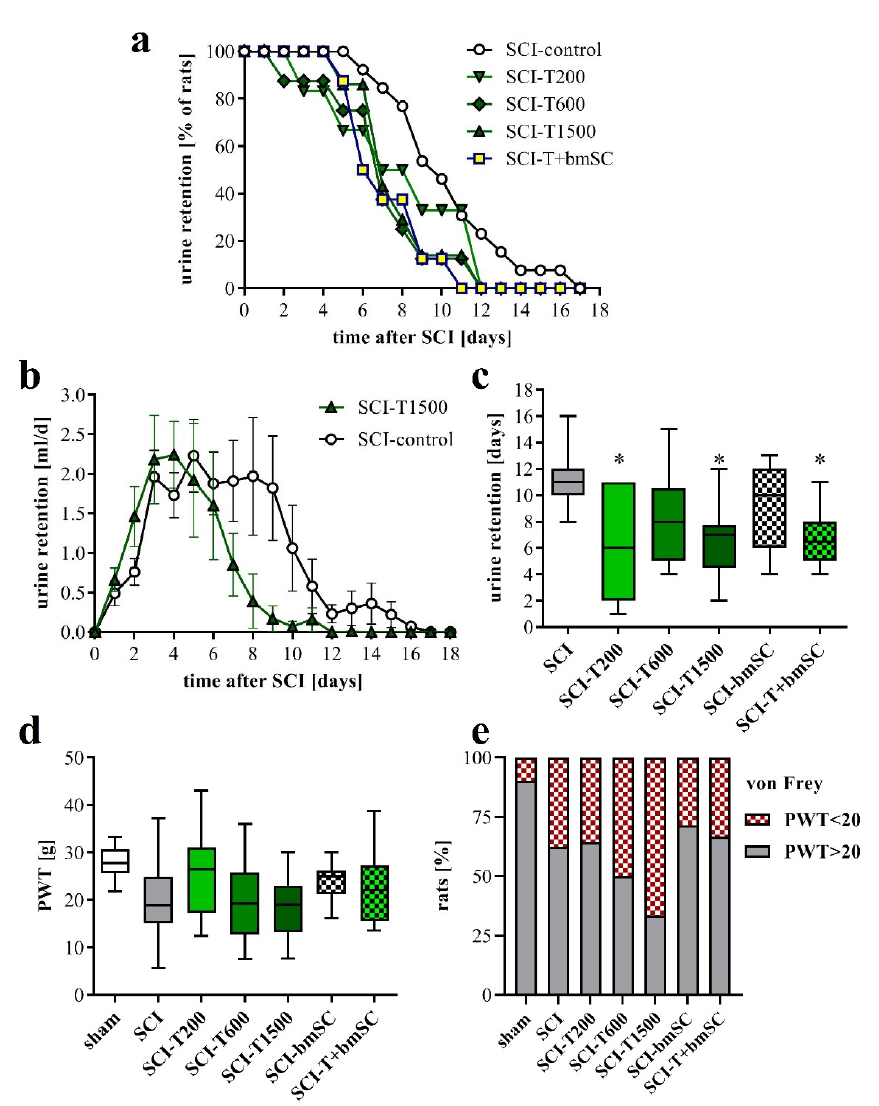
Figure 2. Autonomic functions and neuropathic pain. ( a ) Percentage of rats that required manual bladder voiding each day in the post treatment period. Bladders were voided manually every 12 h. ( b ) Average volume of retained urine per day and rat. Data shown here are for the SCI rats treated with saline and with five injections of TUDCA (mean ± SEM). ( c ) Time after SCI that passed until the animals no longer required manual voiding of the bladder [ANOVA, F (5, 43) = 2.7, p < 0.05; post hoc Dunnett’s test vs. SCI control * p < 0.05]. ( d ) To assess neuropathic pain we measured